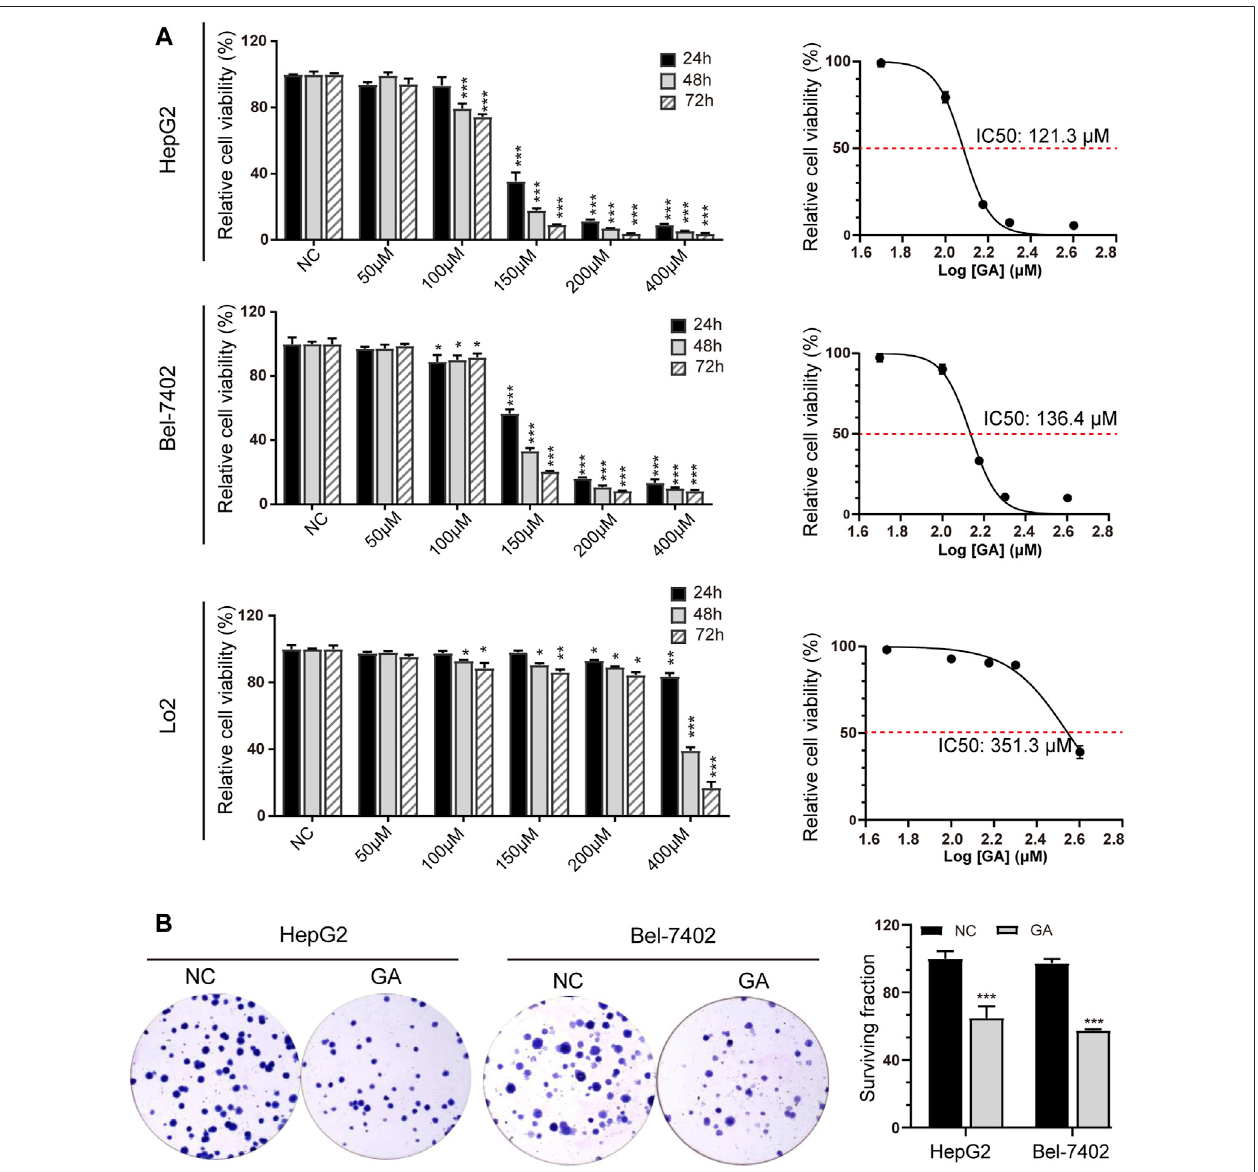
FIGURE 1 | GA signi fi cantly suppressed cell viability in HCC cells. (A) HepG2, Bel-7402 and LO2 cells were treated with various concentrations of GA (0, 50, 100, 150, 200 and 400 μ M), and cell viabilities were measured by CCK-8 assays and the IC50 values were calculated and presented. The data was shown as mean ± SEM ( n (cid:2) 5). (B) HepG2andBel-7402cellsweretreatedwith120 μ M GAfor48 handsubsequentlyre-platedinto6-wellplatesandculturedfor2 weekstoassessclonogenic ability. *, p < 0.05; **, p < 0.01; ***, p < 0.001; vs NC.